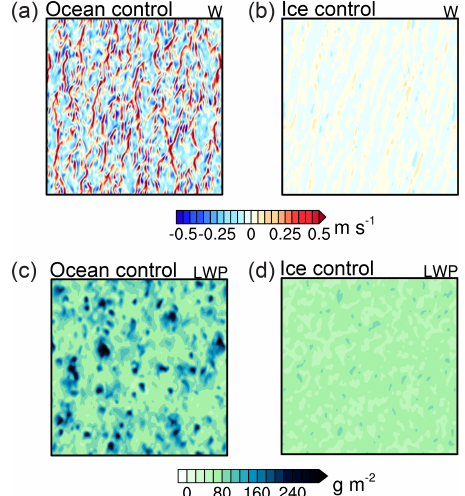
Figure 3. Snapshot at 3h simulation time of (a, b) sub-cloud updraft speed at 100m and (c, d) LWP for the ocean_control (a, c) and the ice_control case (b, d)